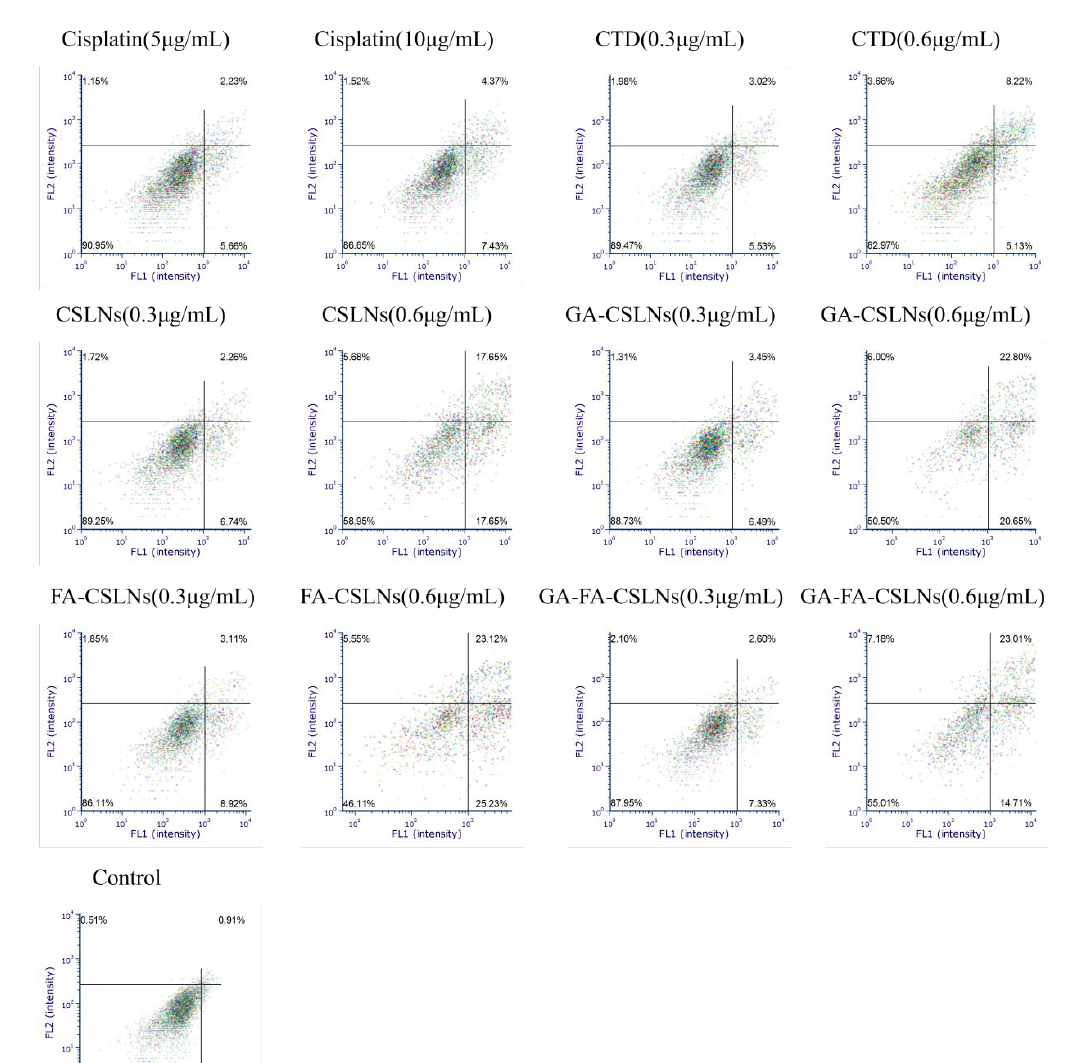
Figure 9. Apoptosis of HepG2 cells with CSLNs modified by different ligands.